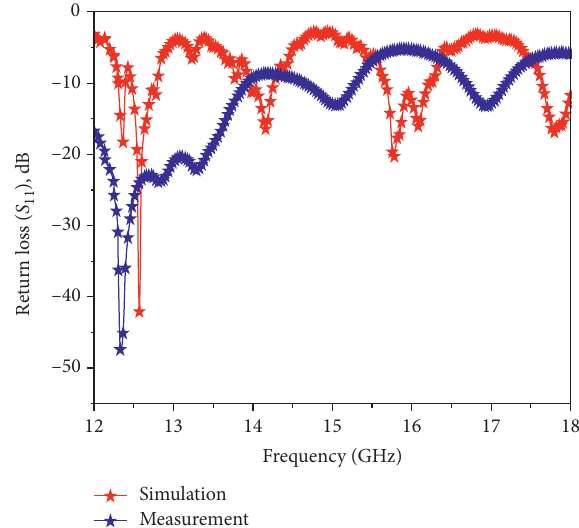
Figure 9: Measured and simulated return loss of the